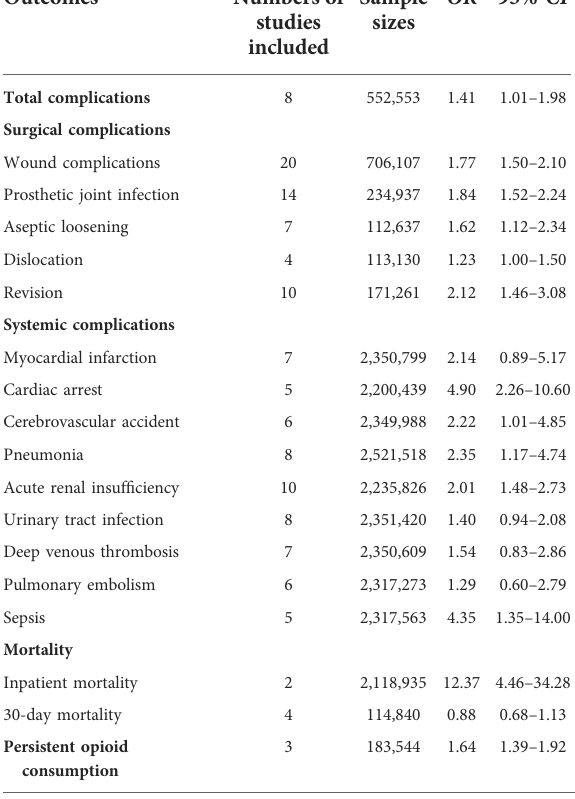
TABLE 2 Outcomes of